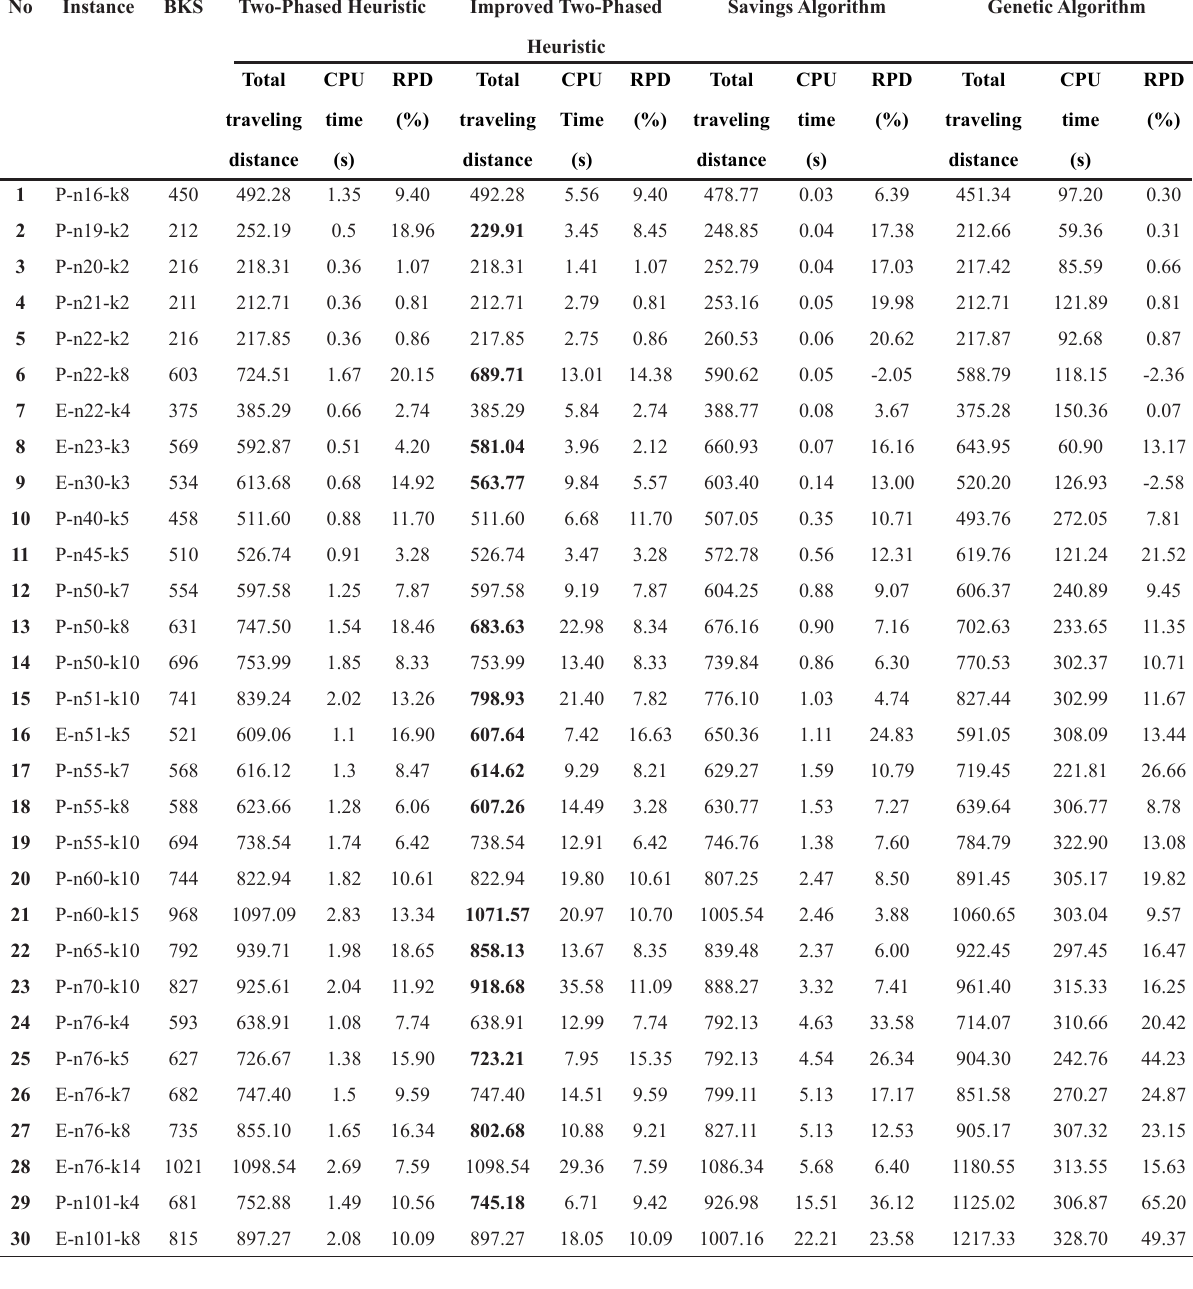
Table 2: Computational results of four heuristic algorithms.